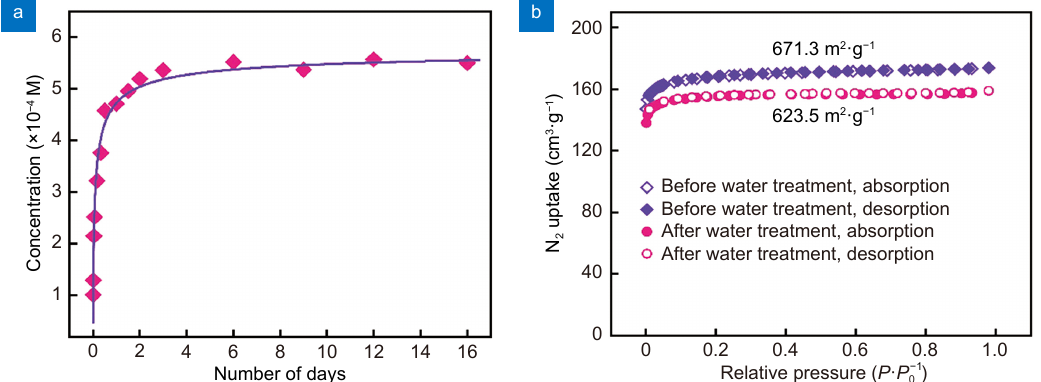
Fig. 2 | ( a ) The concentration of dissolved ligand H 2 BDC-NH 2 in Eu(BDC-NH 2 ) suspension at different time. ( b ) N 2 sorption isotherms of Eu(BDC- NH 2 ) before (red) and after (blue) being treated with water at 77 K. Solid symbols: adsorption, open symbols: desorption.